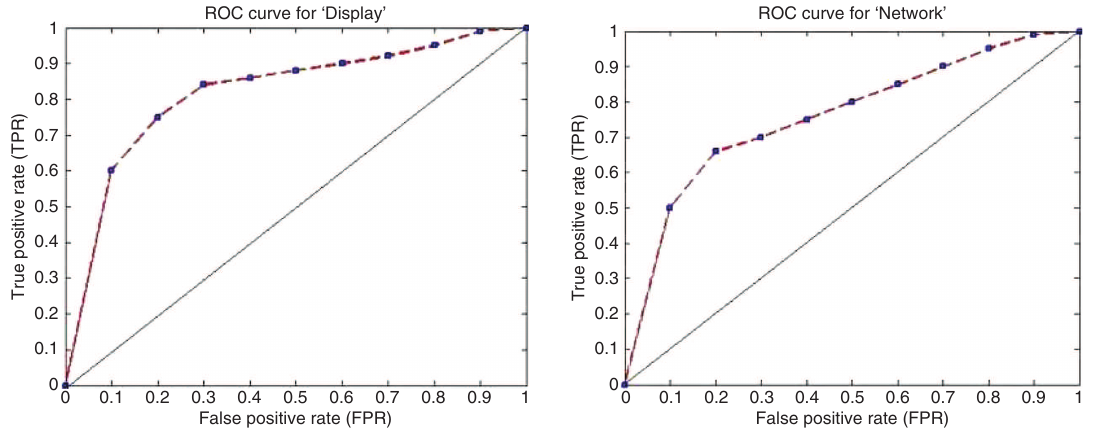
Figure 3: ROC Plots for “Display” and